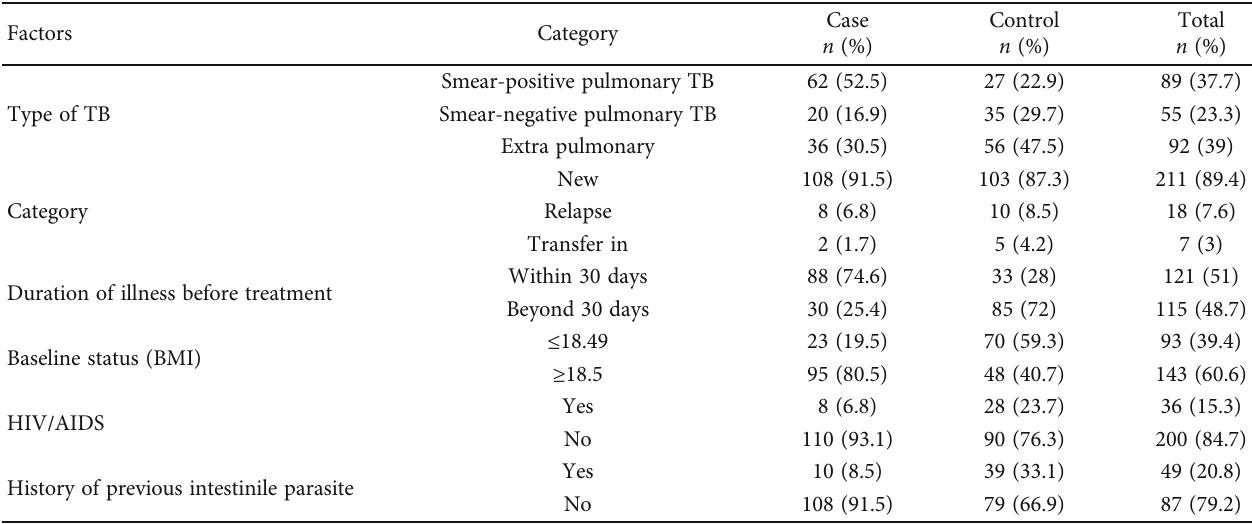
Table 3: Clinical related factors during an intensive phase in Debre Markos town public health facilities, Northwest Ethiopia, 2020. Factors